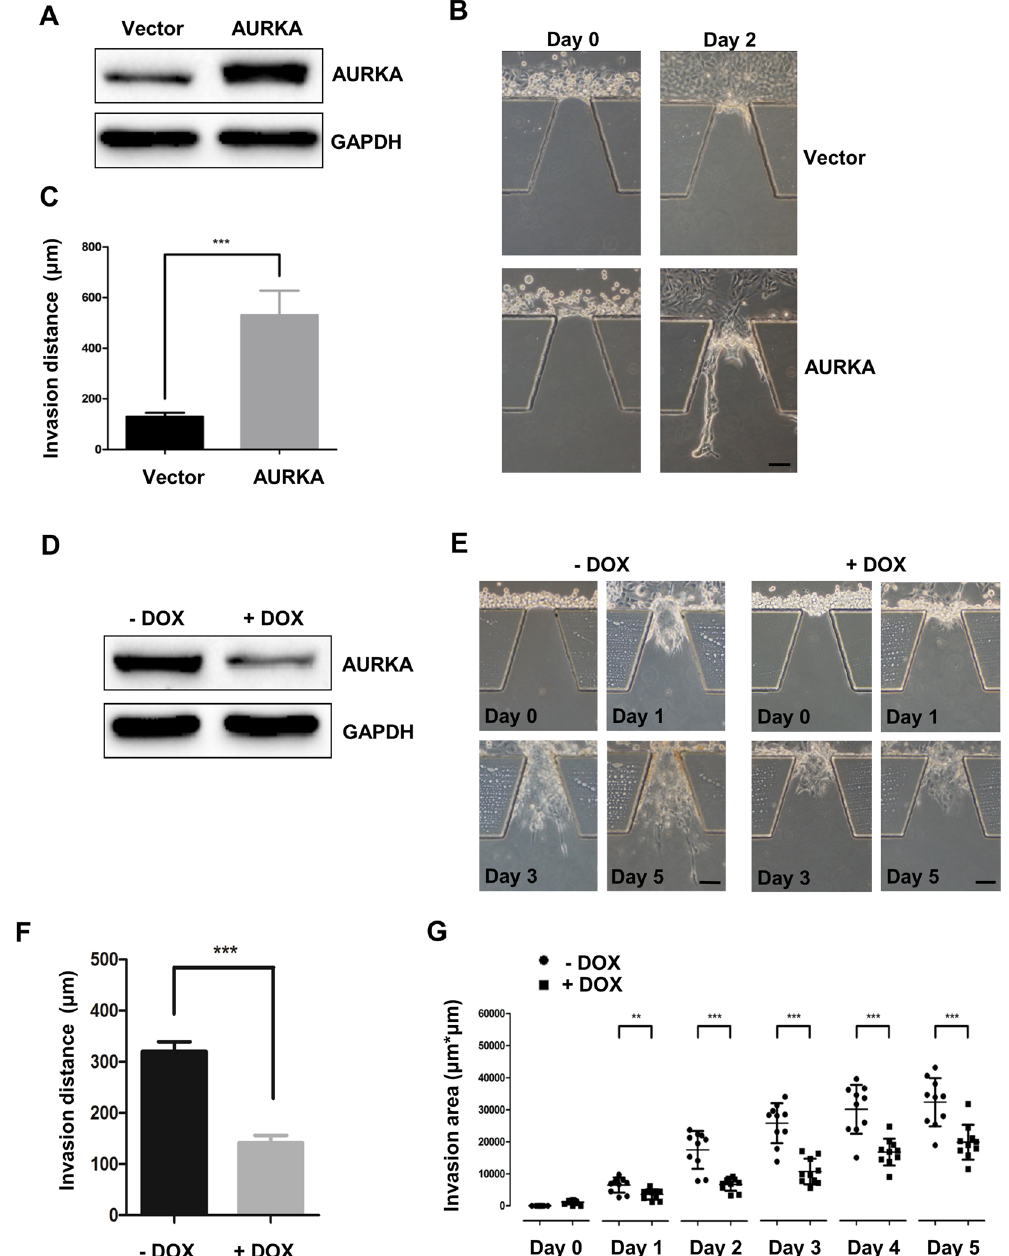
Figure 3. AURKA regulates collective cohort formation during tumor cell invasion. ( A ) AURKA overexpressed or control MCF-10A cells were subjected to western blot analysis. ( B ) AURKA overexpressed or control MCF- 10A cells were seeded in microfluidic chip. Images were taken at day 0 and day 2 respectively. Scale bar: 100 μ m. ( C ) Invasion distance of collective cohorts at day 2 in 10 duplicated galleries were counted and were presented as the means ± SD ( *** P < 0.001, Student t test). ( D ) Endogenous AURKA was conditional knocked down via treating with 0.2 μ M doxycycline in MDA-MB-231 tet-on shAURKA cells. ( E ) MDA-MB-231 tet-on shAURKA treated with or without doxycycline were seeded in microfluidic chip. Images were taken at day 0, day 1, day 3 and day 5 respectively. Scale bar: 100 μ m. ( F ) Invasion distance at day 5 were measured. Data summarized 10 duplicated galleries and were presented as the means ± SD ( ** P < 0.01, Student t test). ( G ) Invasion areas were calculated at day 0 to day 5 respectively ( ** P < 0.01; *** P < 0.001 Student t